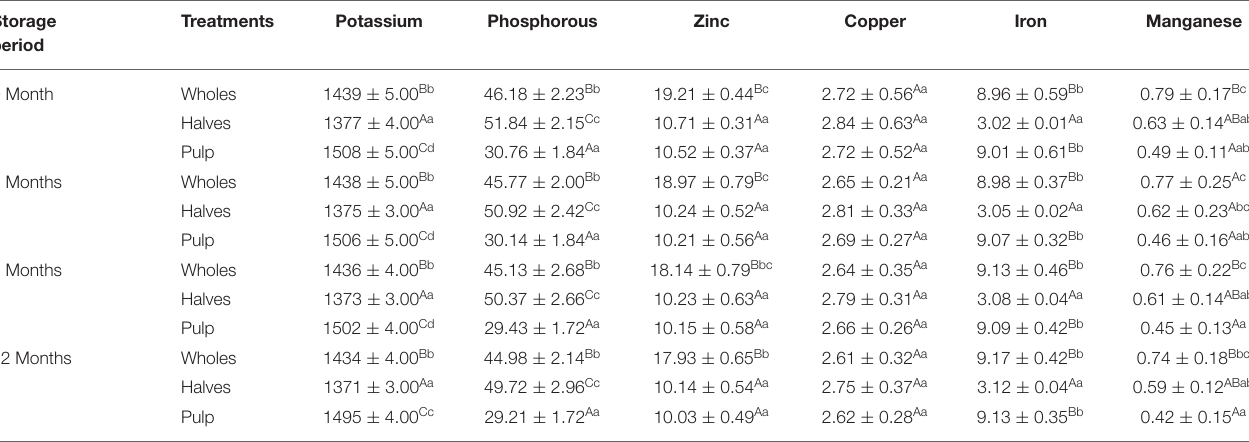
TABLE 2 | Effect of canning and storage on mineral composition of apricot wholes, halves and pulp. Storage